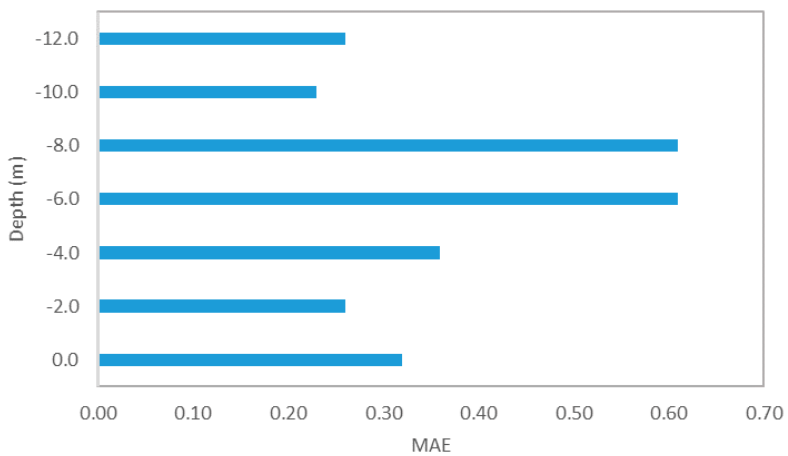
Figure 3. Variation of MAE errors versus depth (m).